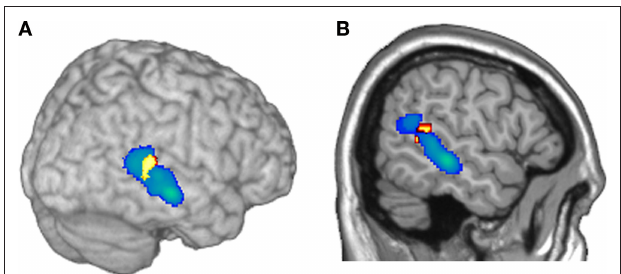
FIGURE 6 | Illustration of the anatomical overlap of brain activity in the right pSTS of the sender and the receiver. Cerebral activity evoked in the sender during the planning of communicative actions is shown in yellow/red; cerebral activity evoked in the receiver during the observation of the communicative actions is shown in: (A) 3D rendering, and (B) sagittal section).